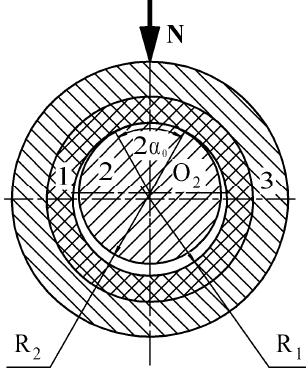
Figure 2. Calculated scheme of linear cylindrical plain